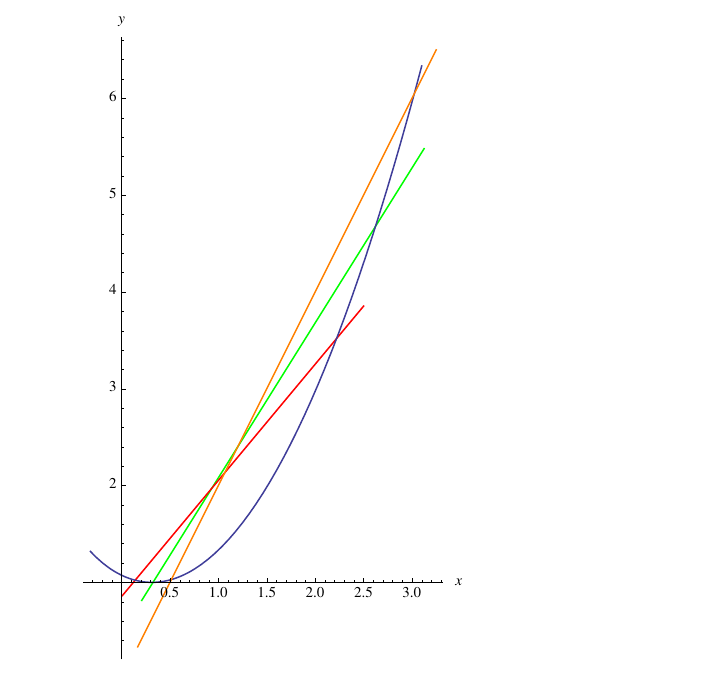
Figure 11 . The 2 d geometry obtained by projecting through the identity 0. The blue curve is the block vectors parametrized by y = G 3 =G 1 ; x = G 2 =G 1 as in (7.7). The unitarity polytope is (cid:1) (cid:1) (cid:1) (cid:1) constructed from the convex hull of points on these curves. The red ((cid:1) (cid:30) = 0 : 3) green ((cid:1) (cid:30) = 0 : 4) and orange ((cid:1) (cid:30) = 0 : 5) lines are the crossing planes X [(cid:1) (cid:30) ] with various external dimensions, parametrized as y = 4 (1 4(cid:1) 2 ) + F 2 ; x = F 2 (cid:30) 3 4(cid:1) (cid:30) (cid:0)